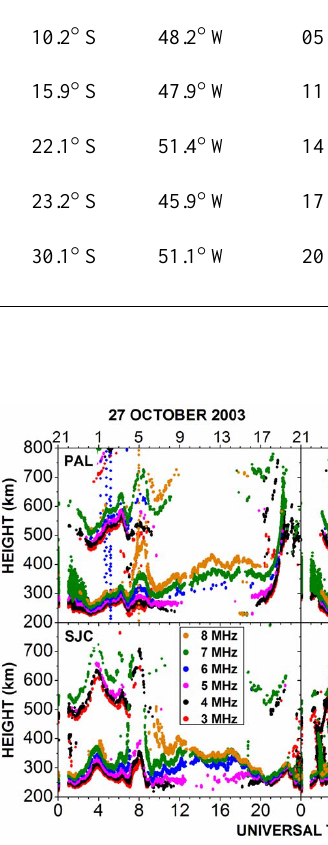
Fig. 2. Plots of virtual height variations for six different frequencies (iso-frequencies 3, 4, 5, 6, 7, and 8MHz.) observed at PAL and SJC for the UT days 27 and 28 October 2003. The vertical red line indicates the peak in solar flare at 11:10